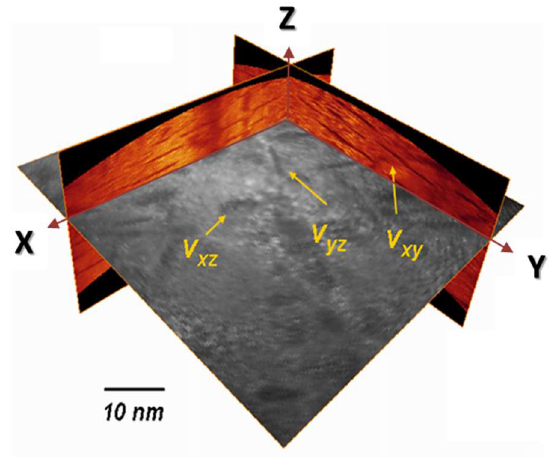
Figure 4. 3D-FIM reconstruction of analysed volume in the nitrided layer, showing the three variants of CrN platelets. CrN platelets appear in dark contrast. The different variants, referred as Vxy , Vyz and Vxz are indicated with yellow arrows.